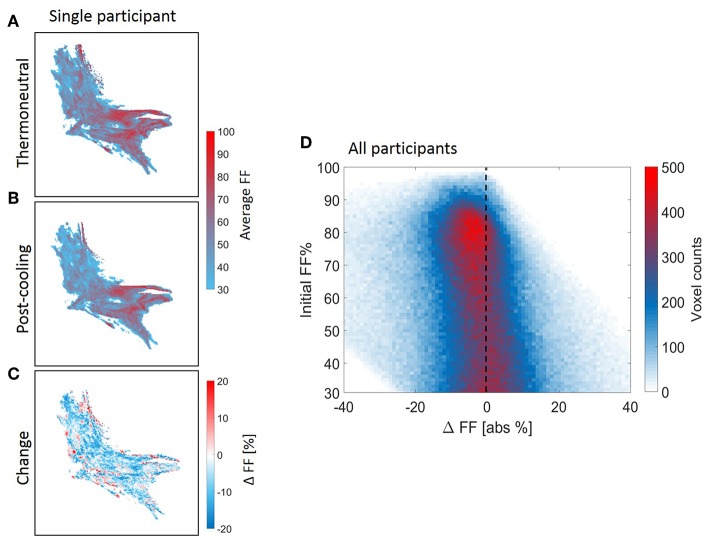
Structural heterogeneity of brown adipose tissue in the supraclavicular region during cold exposure. Example of a reconstructed fat fraction map with merged z-slices before and after cooling (A,B) and cold-induced change (post-minus pre) (C) for n = 1. The 2D joint voxel histogram representing variation in change in lipid content of each voxel in relation to its thermoneutral FF from the voxel-wise analysis, wherein the colors represent the number of voxels belonging to each combination (D) for all participants (n = 9). Cold colors indicate decreases in fat fraction and warm colors indicate increases in fat fraction.